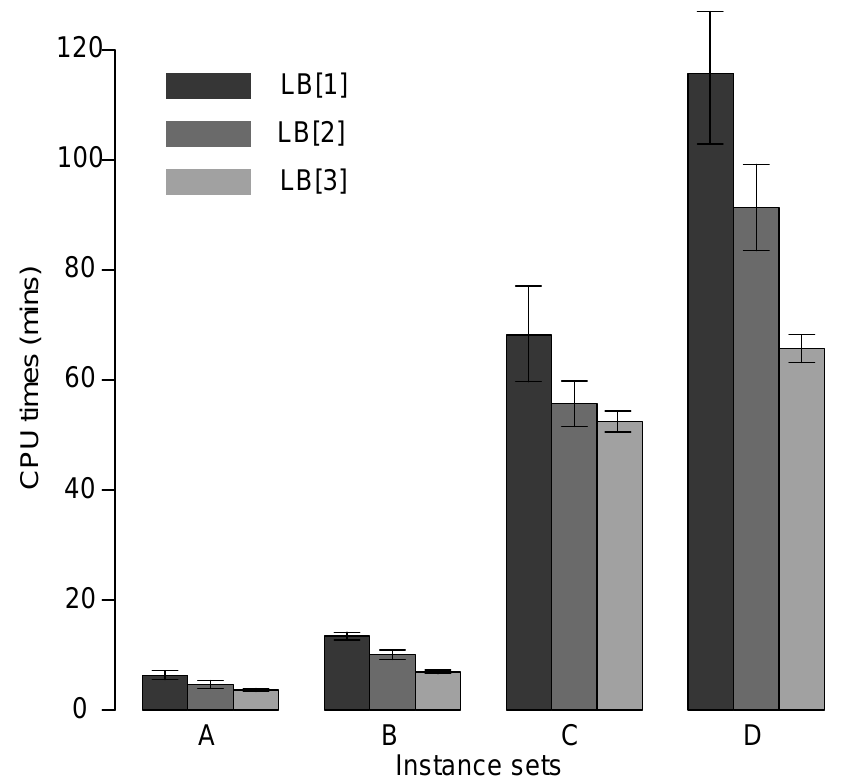
Figure 6. Average computational time of the BaB algorithm with different lower